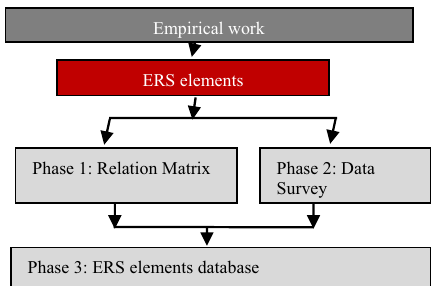
Figure 3. Empirical